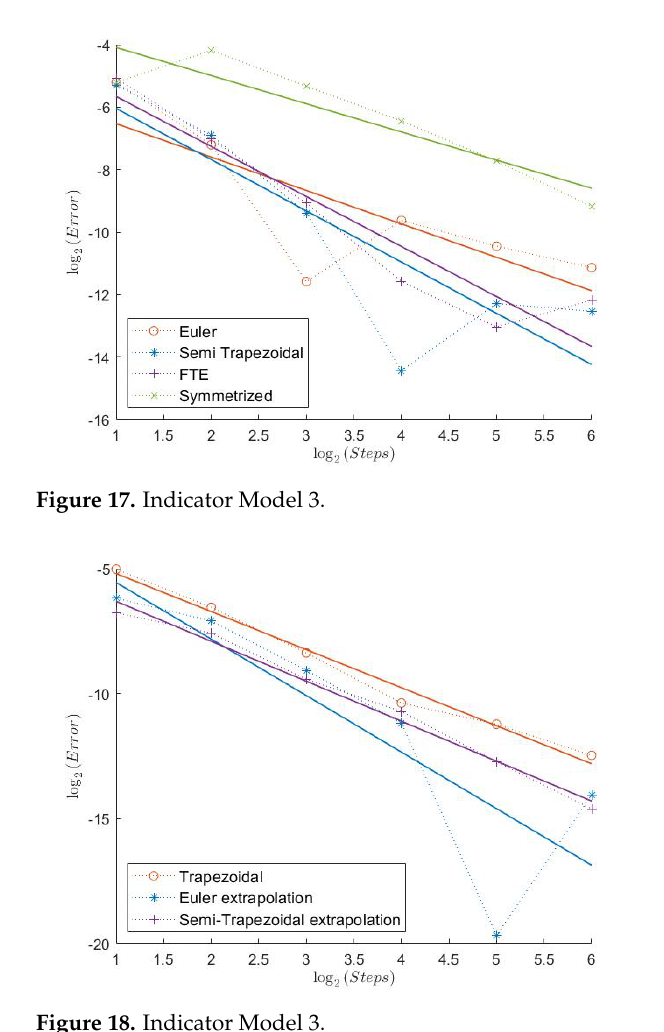
Figure 18. Indicator Model 3.